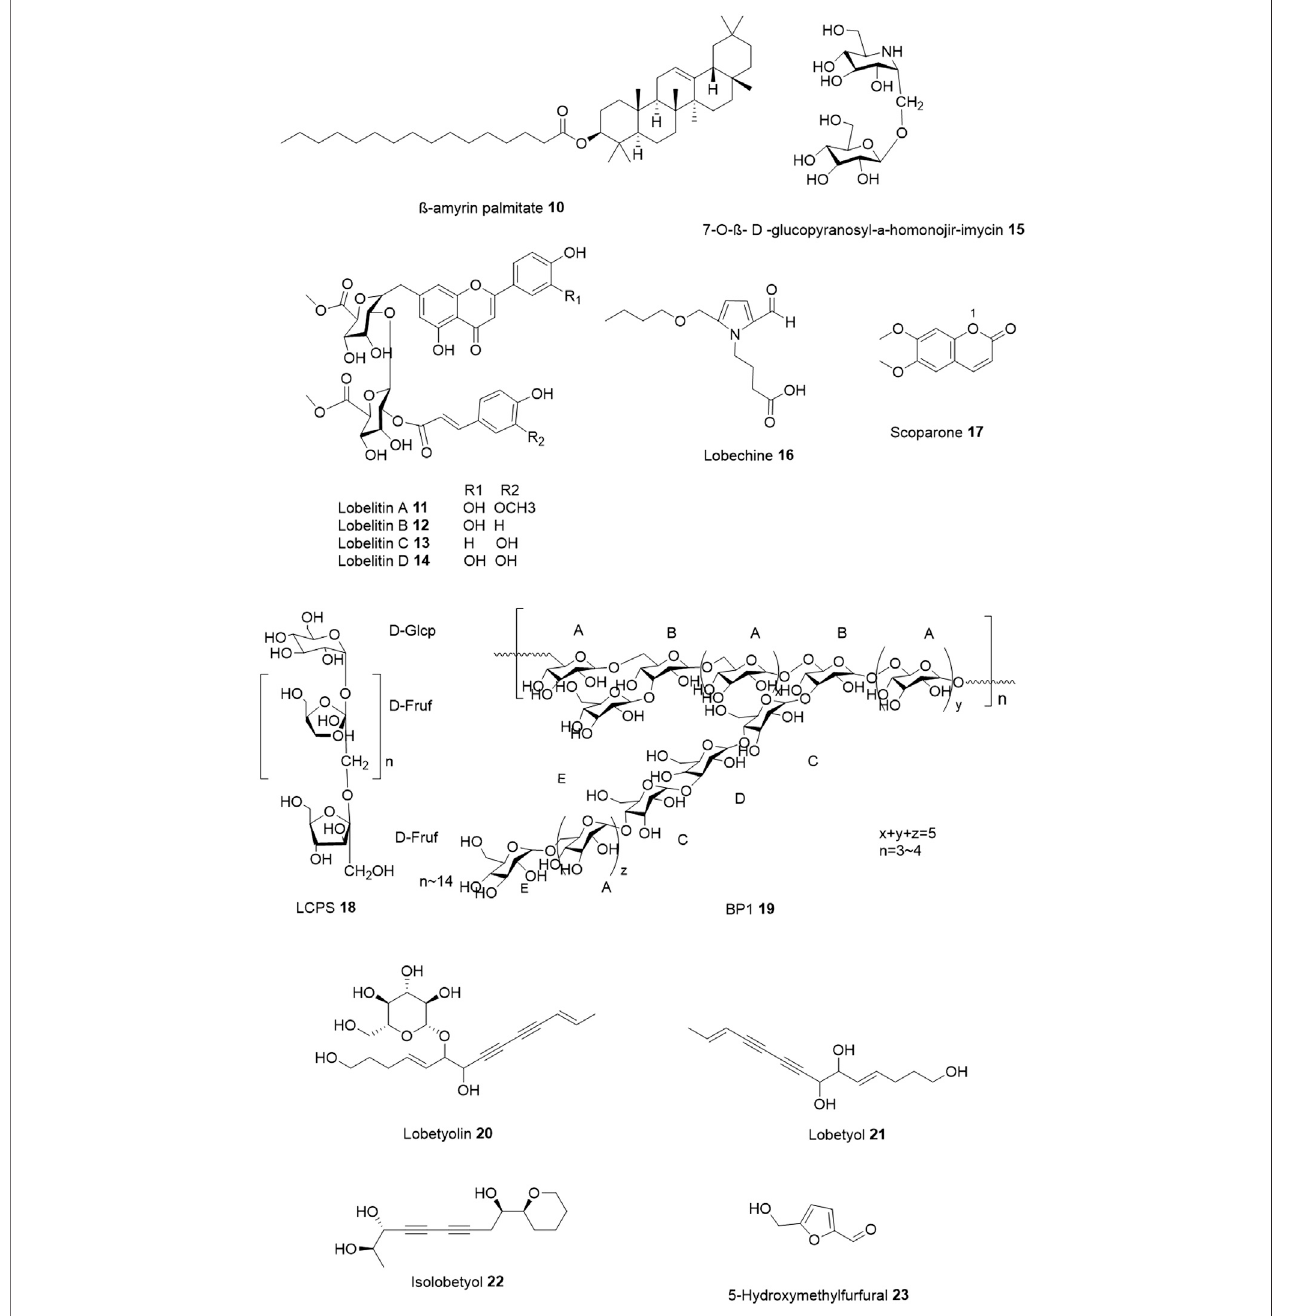
FIGURE 3 | Chemical structures of non-alkaloids novel bioactive compounds isolated from Lobelia species.